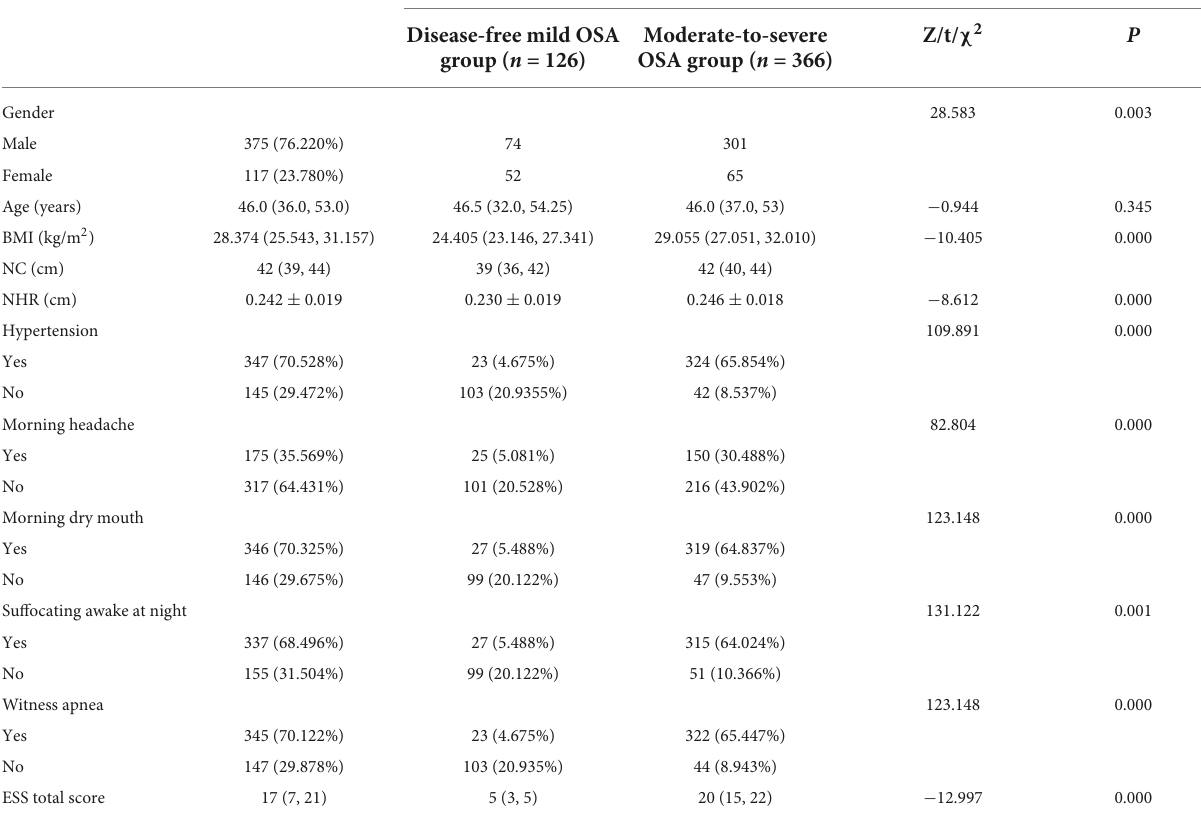
TABLE 1 Information about the study subjects and single-factor